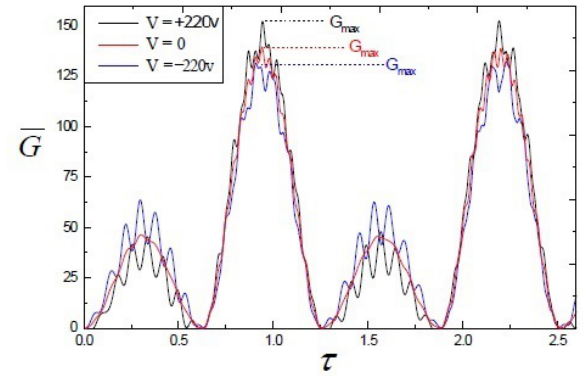
Fig. 4. Effect of voltage on energy release rate of delaminated piezo- electric shell.